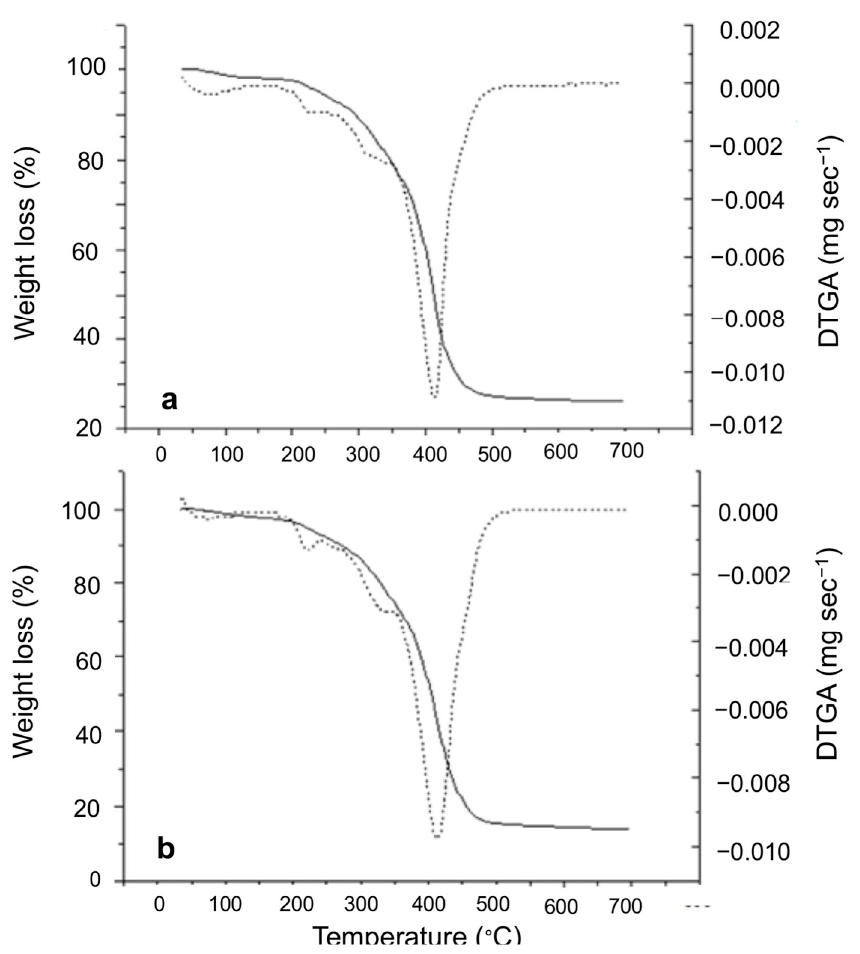
Figure 2. Thermogravimetric ( ) profiles and first derivative curves ( ) at day 0 obtained for roasted ( a ) and fried ( b ) sunflower seed samples.